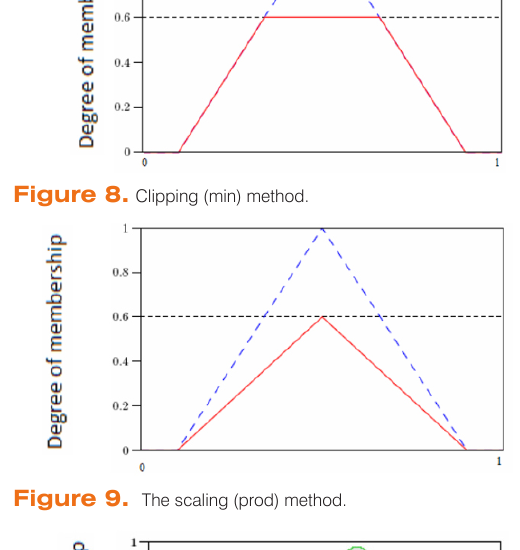
Figure 9. The scaling (prod) method.